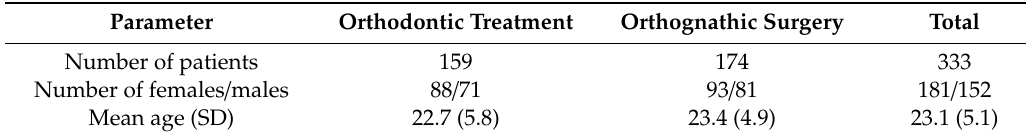
Table 1. Characteristics of the samples.